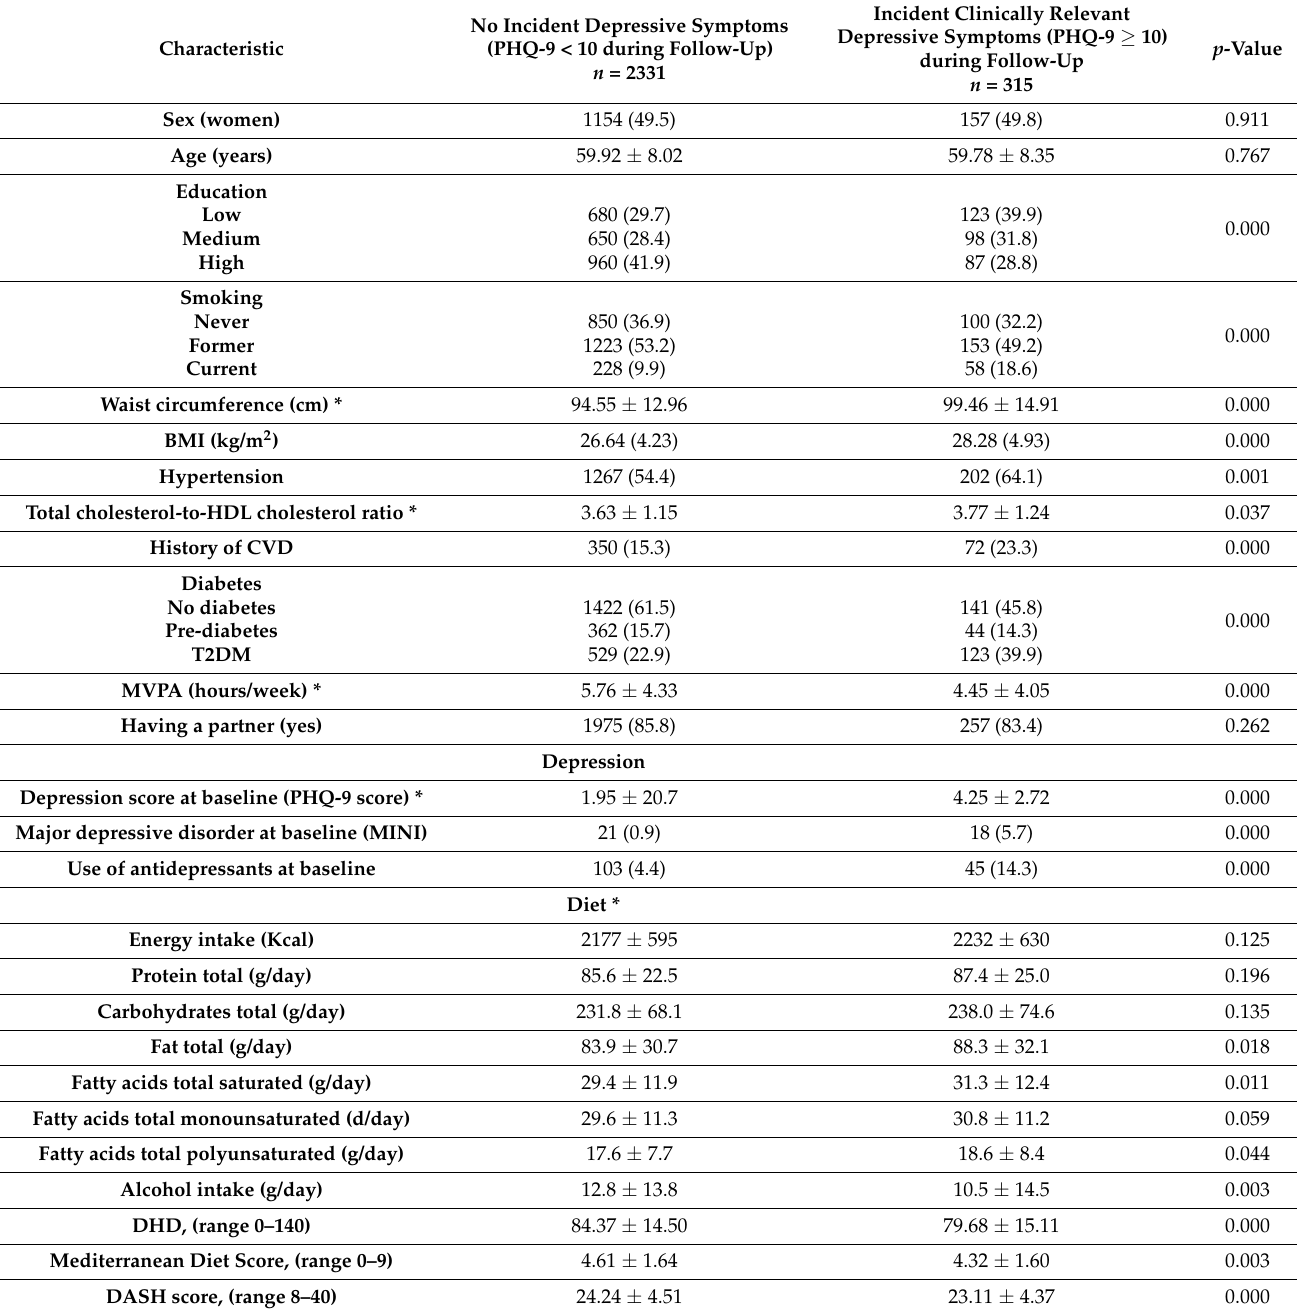
Table 1. Baseline characteristics of the study population stratified by incident clinically relevant depressive symptoms.